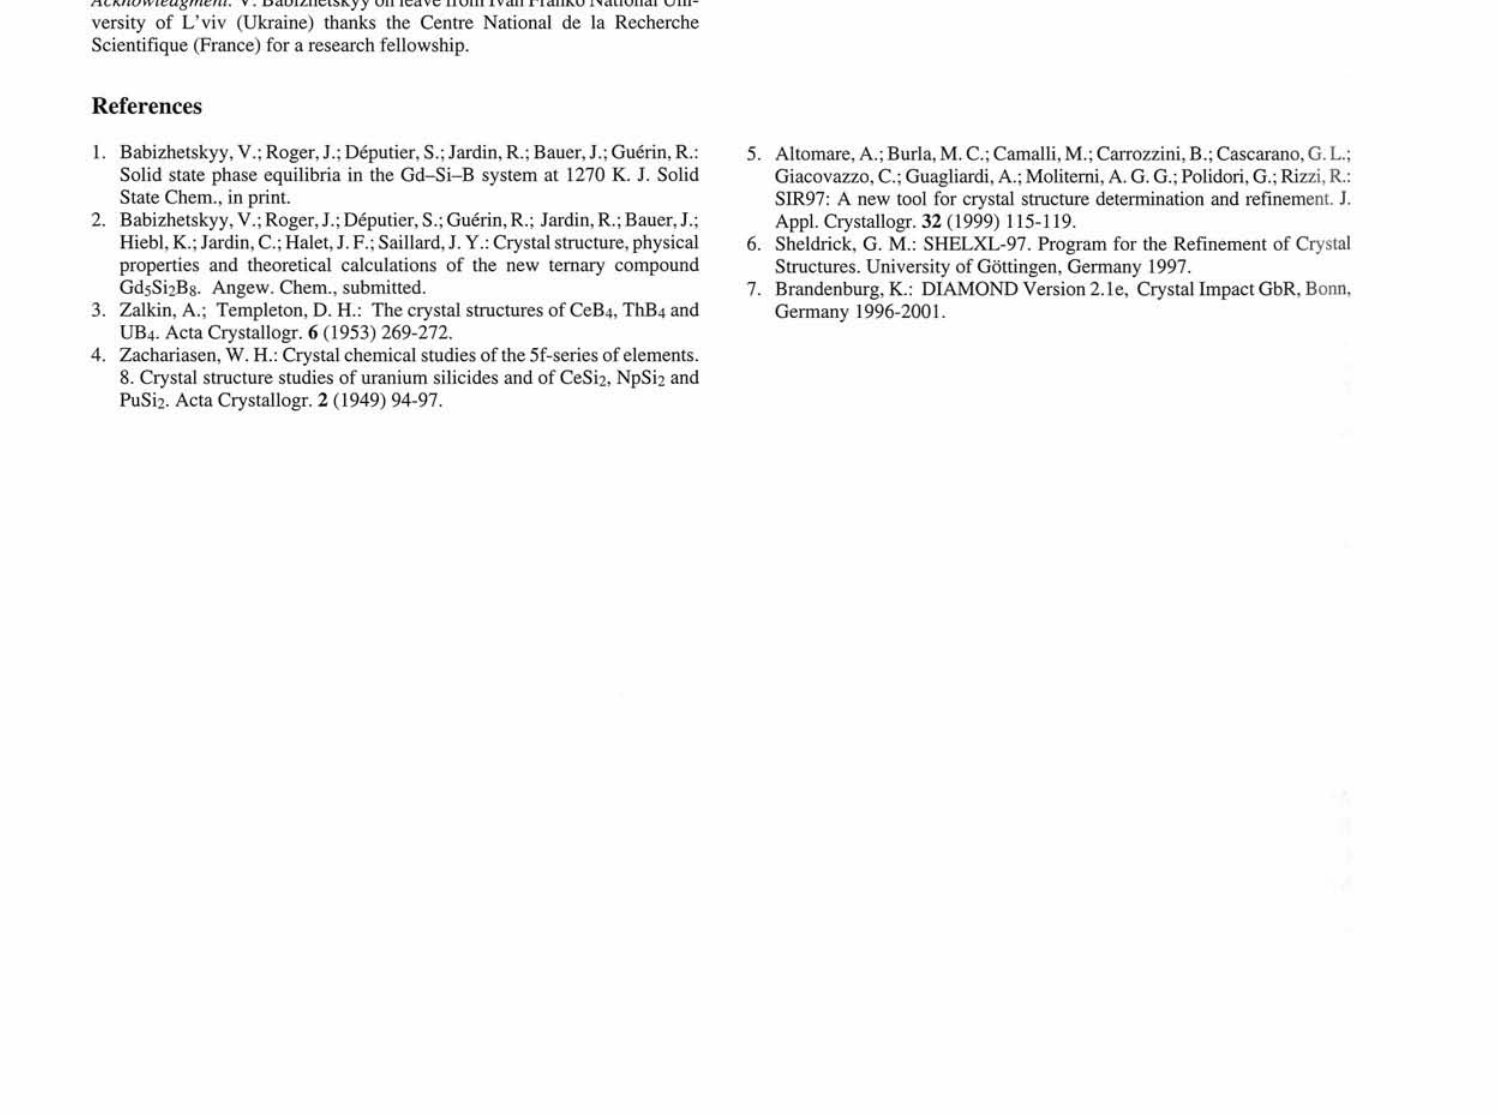
Table 2. Atomic coordinates and displacement parameters (in À 2